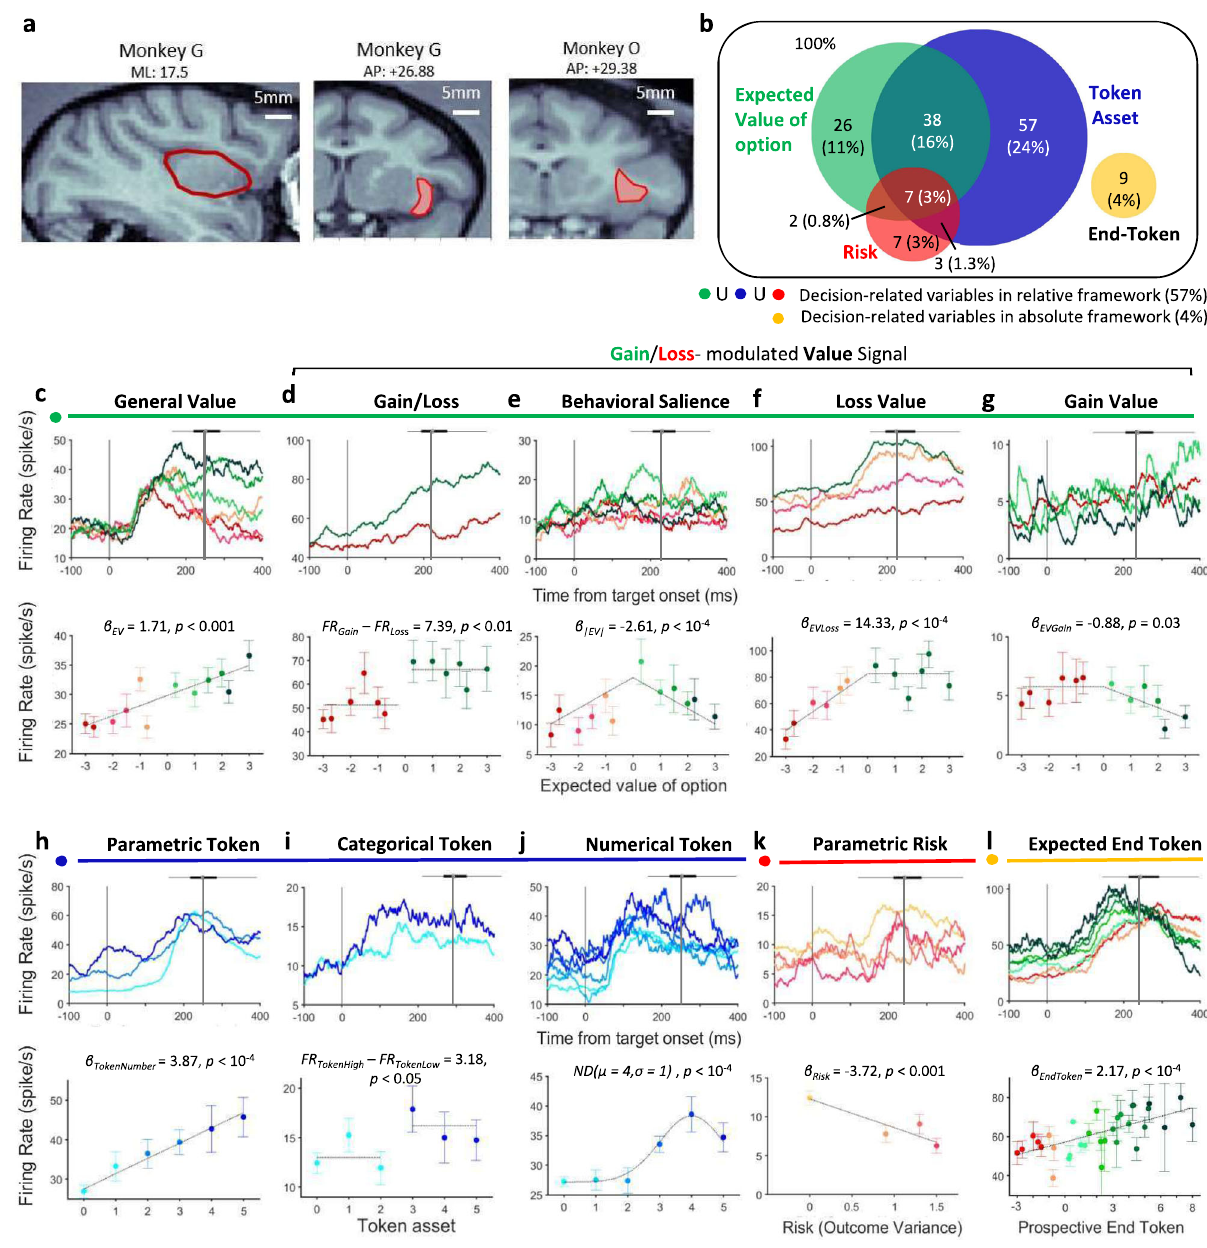
Fig. 3 AIC neurons encode diverse task-related variables in forced-choice trials. a MRI images showing the area of recording of each monkey. Left and middle: sagittal (left) and coronal (middle) view of the insular cortex of monkey G. Right: coronal view of the insular cortex of monkey O. b Venn diagram of the neurons encoding four types of task-related variables in the forced-choice trials. Green: expected value of option; Blue: start token number; Red: risk (variability of potential outcomes); Yellow: expected end token number. c – g Example neurons showing a variety of patterns by which gain/loss context and/or the expected option value (EV) were encoded. c General value signal: monotonic encoding of value across gain/loss contexts. d Gain/Loss value signal: categorical encoding of gain/loss context. e Behavioral salience signal: monotonic encoding of value in gain and loss context but with inverse directions. f Loss value signal: encoding of value only in the loss context. g Gain value signal: encoding of the value only in the gain context. h – j Example neurons showing a variety of patterns by which the token information was encoded. h Parametric token signal: monotonic encoding of the start token number. i Categorical token signal: categorical encoding of the start token number in low and high level. j Numerical token signal: neuronal response tunes to a speci fi c number of start token (here 4). k Example neuron encoding parametric risk (i.e., outcome variance). l Example neuron encoding of the expected end token number. c – l Upper panels: spike density function (SDF), aligned on target onset ( t = 0). Lower panels: mean fi ring rate of each example neuron at different levels of speci fi c task-related variable. Mean fi ring rate (presented as mean values ± SEM) was calculated using the window from target onset to saccade initiation, which varied across trials. The saccade onset distribution is represented as a boxplot on top of each SDF. The box plot indicates median (vertical middle line), 25th, 75th percentile (box) and 5th and 95th percentile (whiskers). For clarity, when plotting the SDF, data were grouped together, as indicated by the color